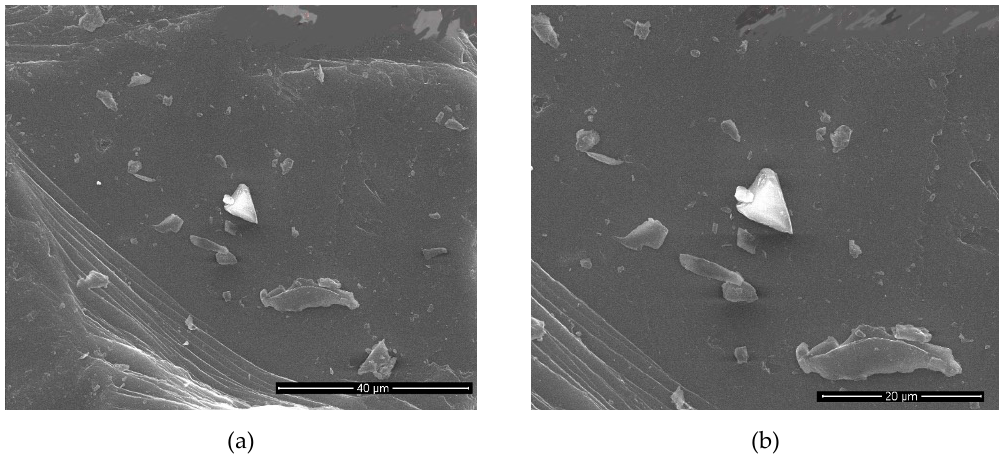
Figure 14. SEM images of M x2c1 sample with a sonication time of 12 h with higher magnification ( a ) 1000×; ( b ) 20,000×.